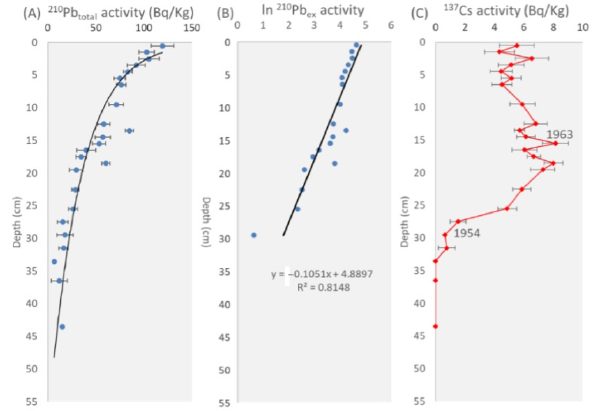
Figure A2. Profiles of the 210 Pb total activity ( A ), the Ln 210 Pb excess activity ( B ), and 137 Cs activity ( C ) of the low marsh core.